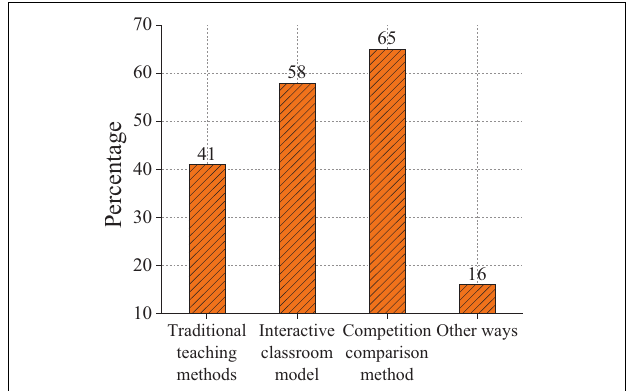
Figure 7 reveals that there are differences in learning